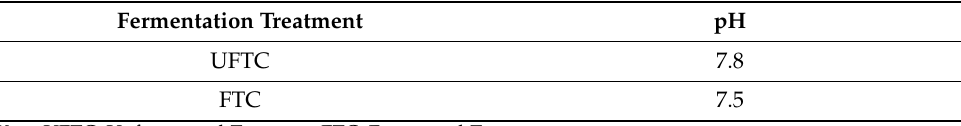
Table 1. The pH values during fermentation of the seed of T. catappa .